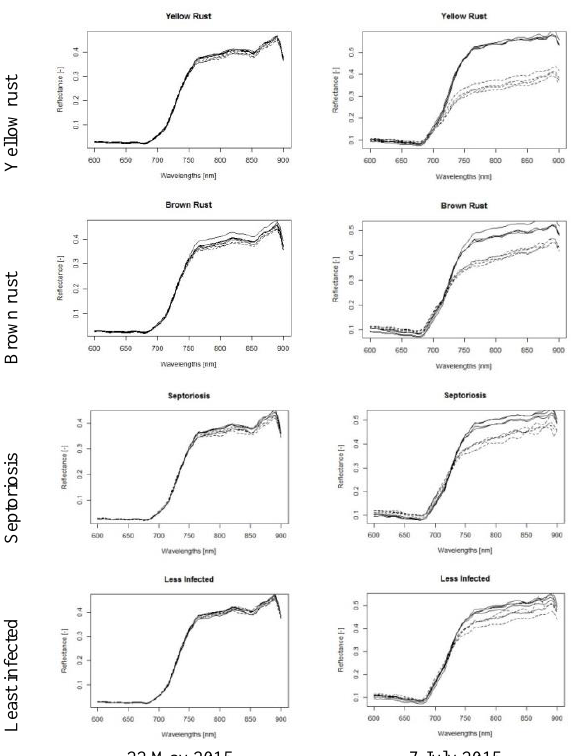
Figure 6. Average reflectance spectra for the 12 selected plots for two of the four RPAS missions. The dashed lines are plots without fungicides treatment, the solid lines are plots with fungicides treatment.